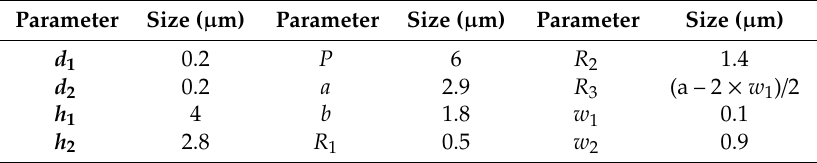
Table 1. Detailed dimensional parameters of the proposed absorber